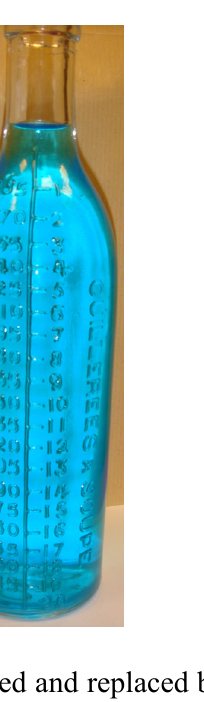
Figure 2. Example of glass bottle showing spoons measurements.